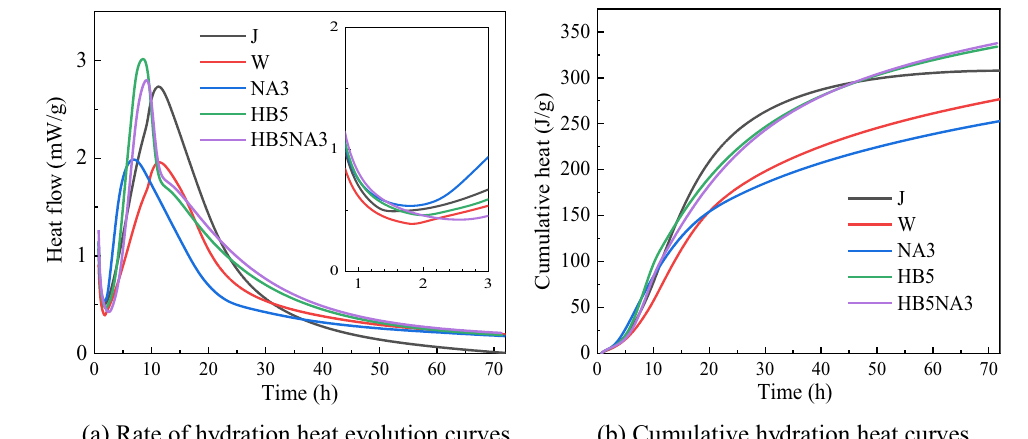
Fig. 15 Isothermal calorimetric analysis of the cement paste samples